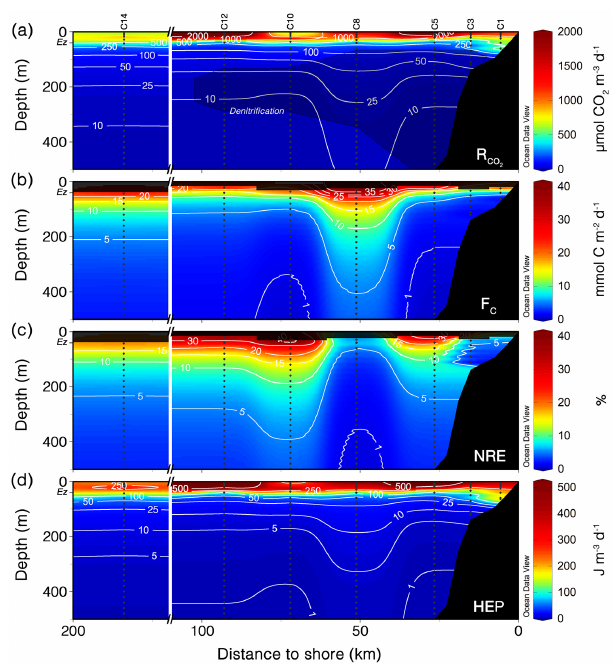
Figure 2. Sections for the upper 500m along the C-line. (a) R CO ; 2 the dark shadow delimits denitrification in the OMZ. In the Ez, R CO is calculated directly from ETS-based R O (Table 3). In the 2 2 mesopelagic waters below, R CO is modeled from the respiration 2 equations in Table 4. (b) F C is calculated by integration of the res- piration models (Table 4) to the ocean bottom according to Eqs. (2) and (3). (c) NRE, as a percentage, is determined from models in Ta- /F C ). (d) HEP is either derived directly bles 4 and 6 as 100 × ( R CO 2 from ETS activity in the surface waters or from calculated R O or 2 R N for depths below the Ez (as in Fig. 2